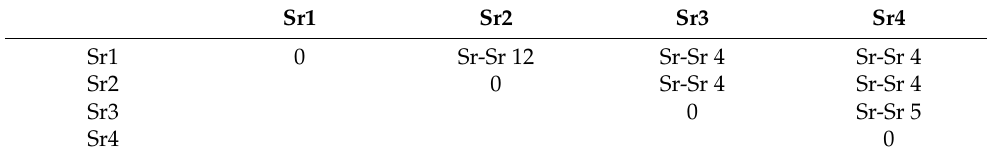
Table A4. Configurational Matrix (mutual interatomic distances in NN, as in Table A2) for x = 0.25.